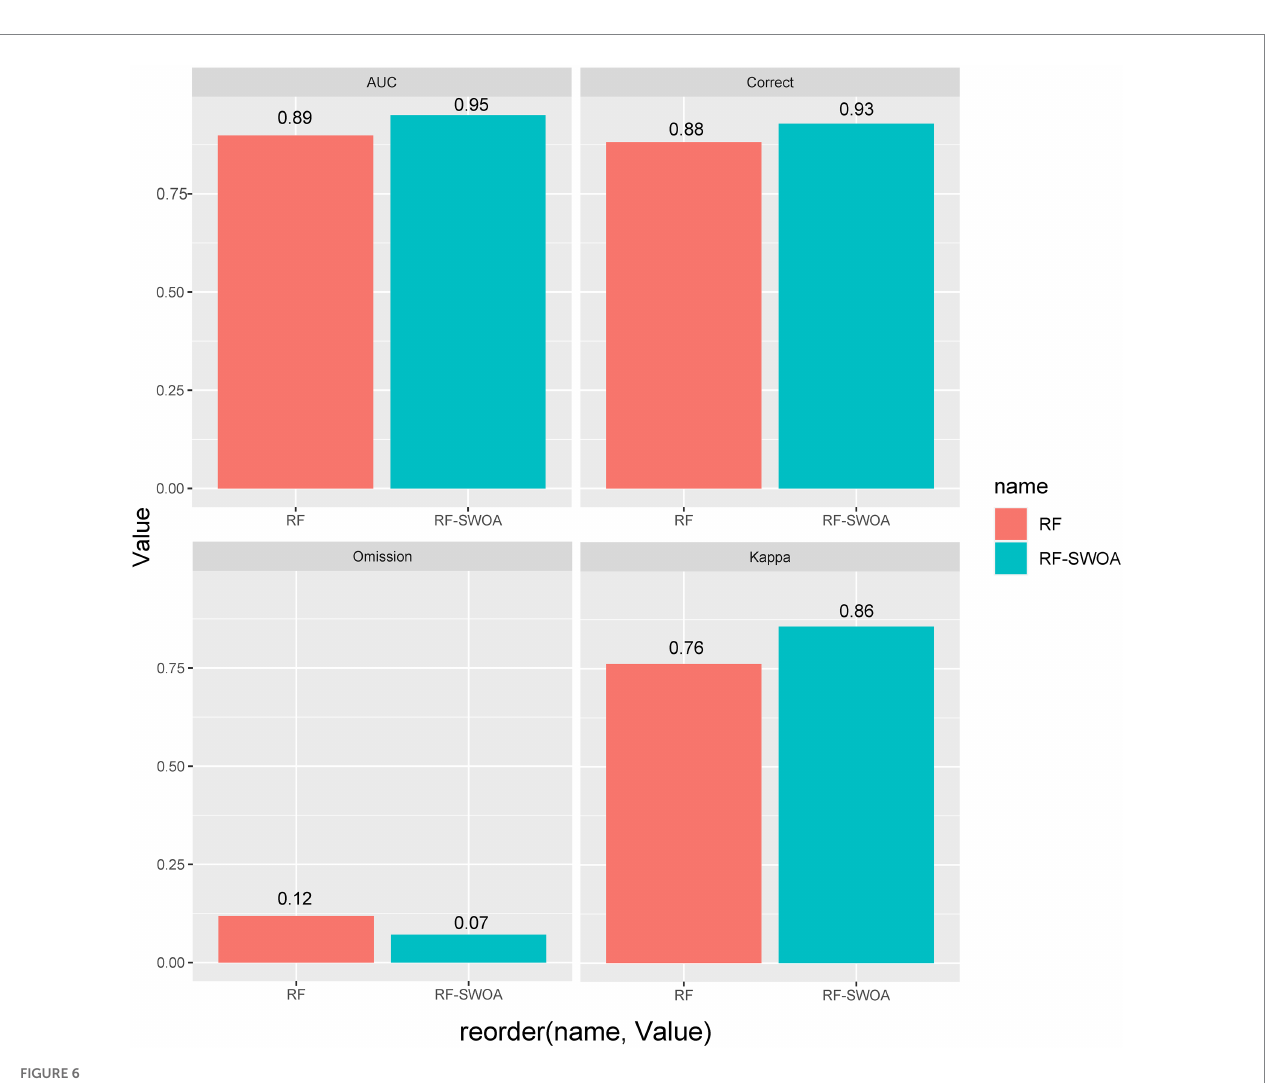
FIGURE 6 RF and RF-SWOA model performance